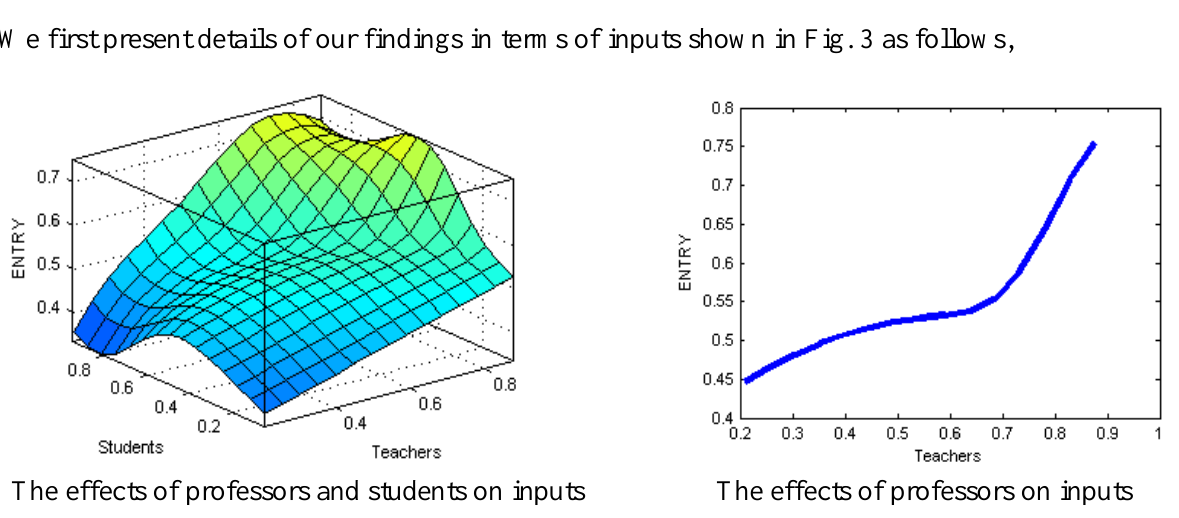
Fig. 3. The effects of university students and professors on inputs